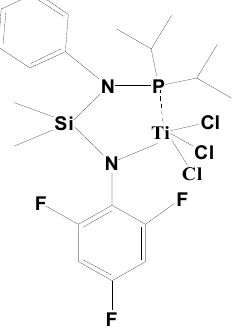
Figure 1. Structure of titanium complex.